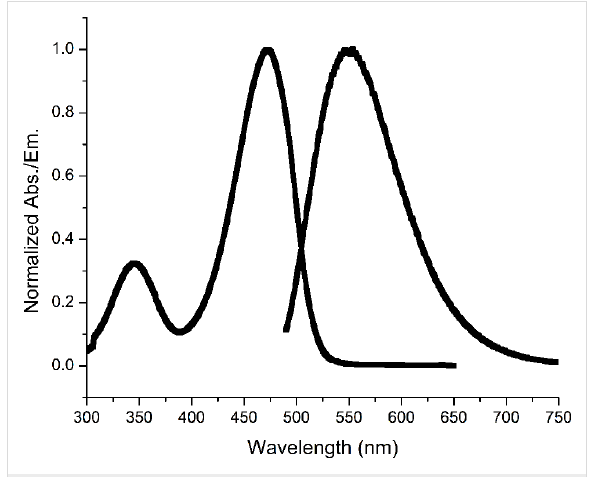
Figure 1: Normalized NBDM absorption and emission, 40 µM and 2 µM.